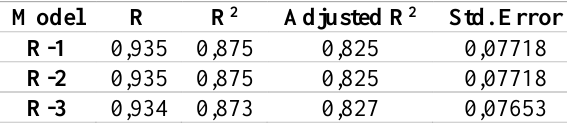
Table 5. Analysis results of regression